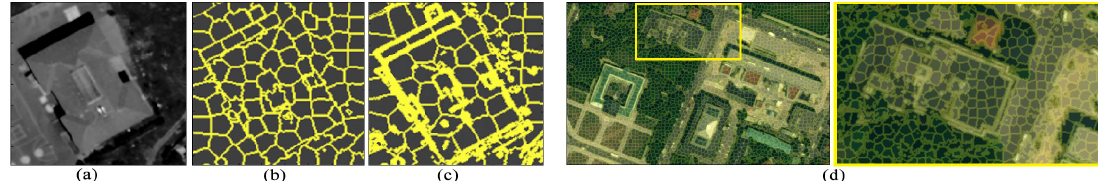
Figure 4. Effect of gradient term on the shape of superpixels; building in a Pan WV-2 image ( a ), superpixels resulting from SLIC ( b ), superpixels resulting from ESLIC ( c , d ). The results shown in ( c , d ) can be compared to Figures 2 and 3b